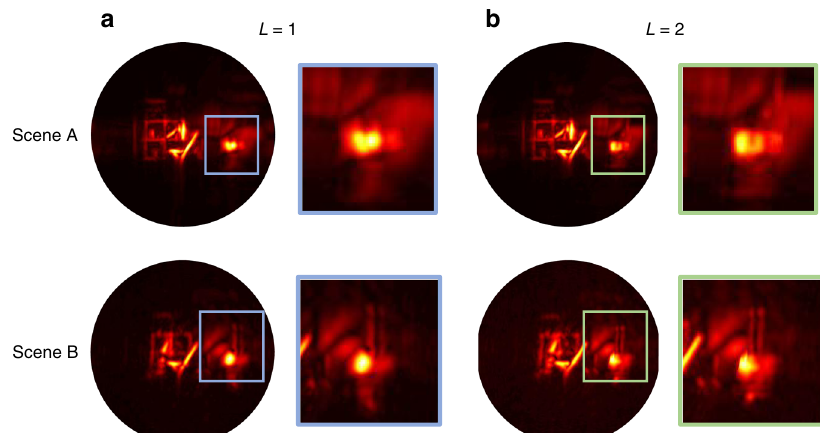
Fig. 5 Larger fi eld of view scenario with two versions of the of fi ce scene. Virtual lens vignetting effect without spatial sectioning (column a ), with spatial sectioning (column b ). Voxels at a given depth z should be computed for a time t when they are actually illuminated by part of the virtual illumination pulse. Using only one distance-time shift ( L = 1 in Eq. (12) for all voxels results in large errors in voxel brightness that lead to a blurry appearance. Using two different distance-time shifts ( L = 2) in different voxel regions results in crisper images. This motivates the spatial sectioning method to mimic a perfect virtual imaging system that is not limited to a small fi eld of